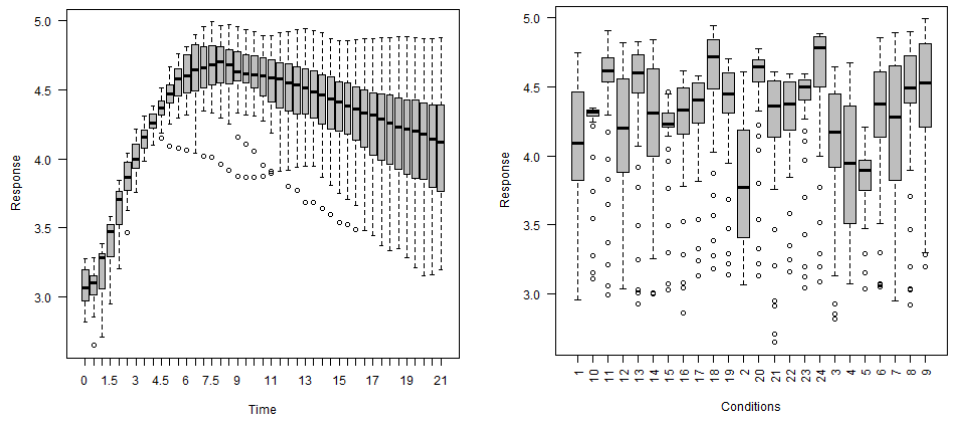
Figure 13. Box-plots of gene expressions PA2975(rluc)(B3) regarding time ( left ) and conditions ( right